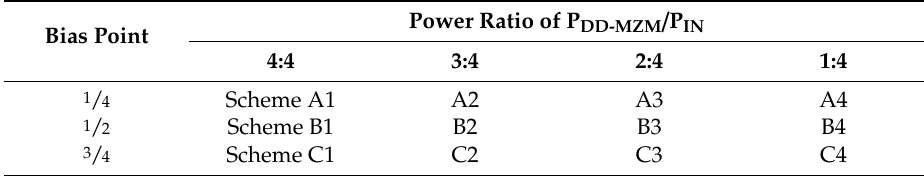
Table 3. Irregular θ scheme based on LD power distribution and variation in DD-MZM bias point. Power Ratio of P DD-MZM / P IN Bias Point 4:4 3:4 2:4 1:4 1 / 4 Scheme